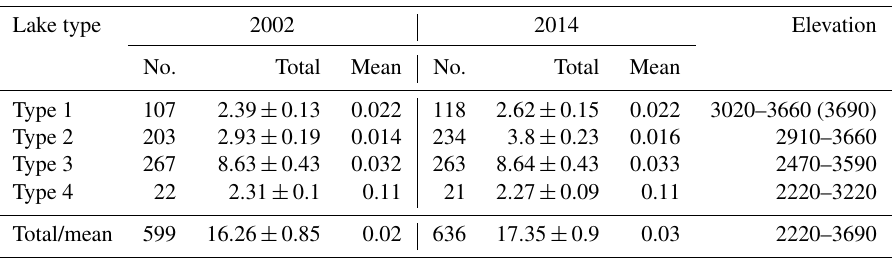
Table 2. Distribution of lakes by type in 2002 and 2014. Lake areas (combined and mean) are in km 2 ; elevation is in ma.s.l. Elevation given in parentheses refers to